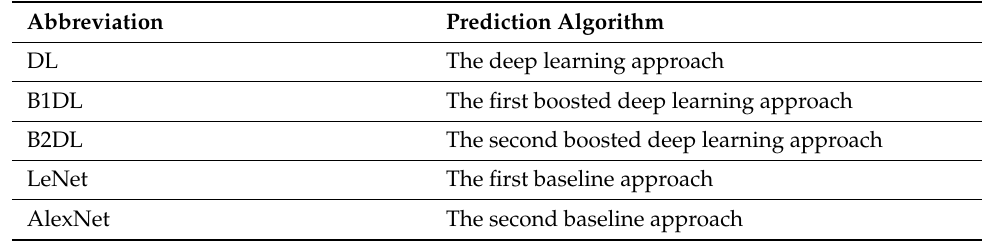
Table 1. Summary of the prediction algorithms used in our study.